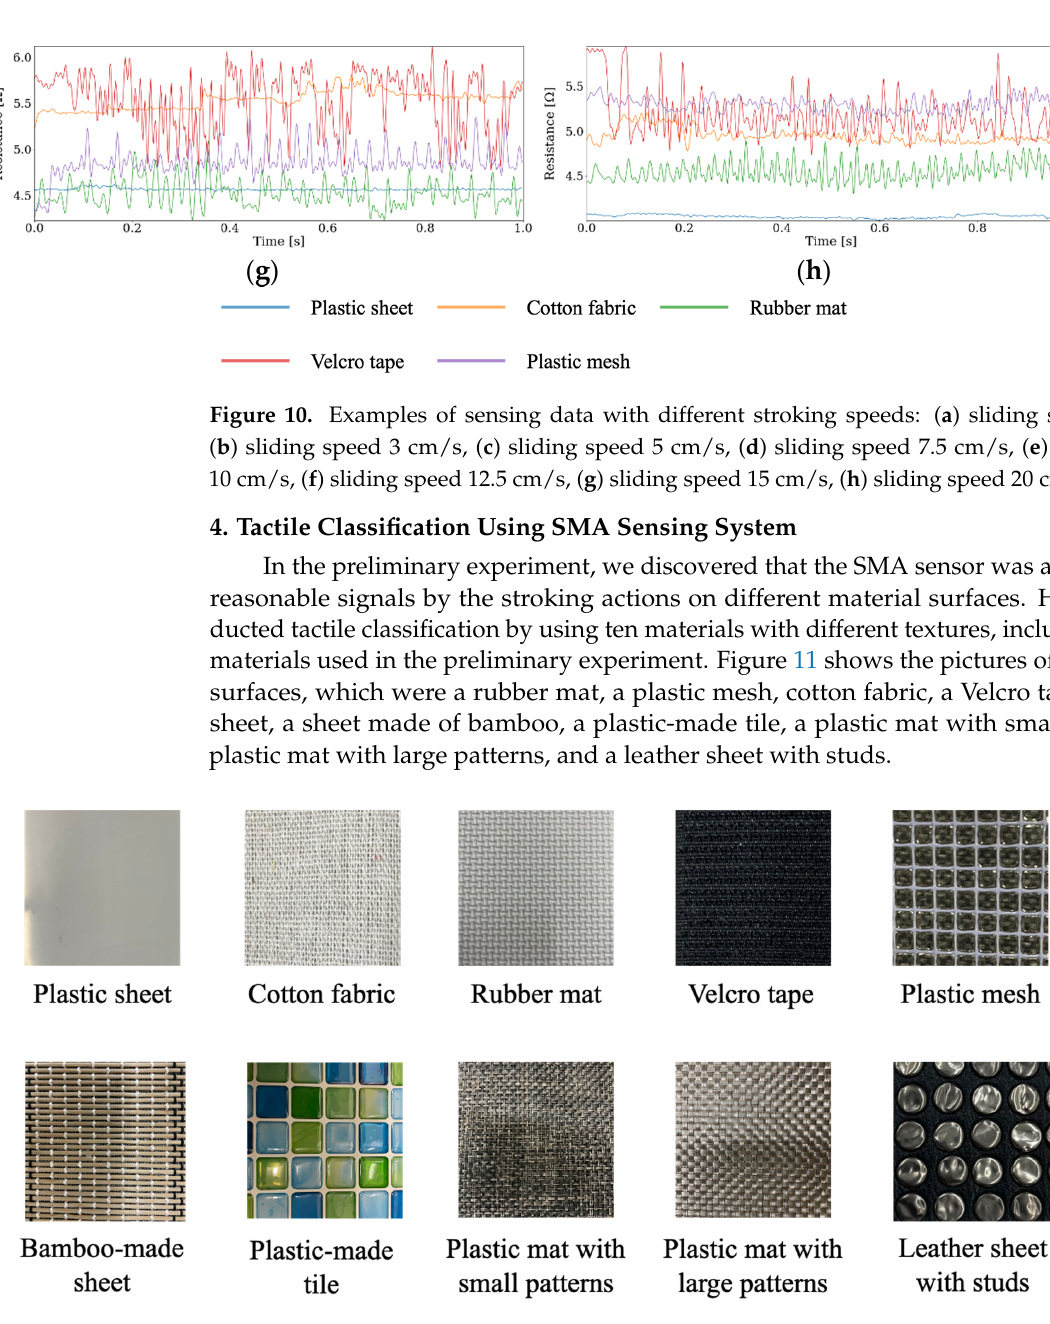
Figure 11. Ten materials for tactile classification experiment.